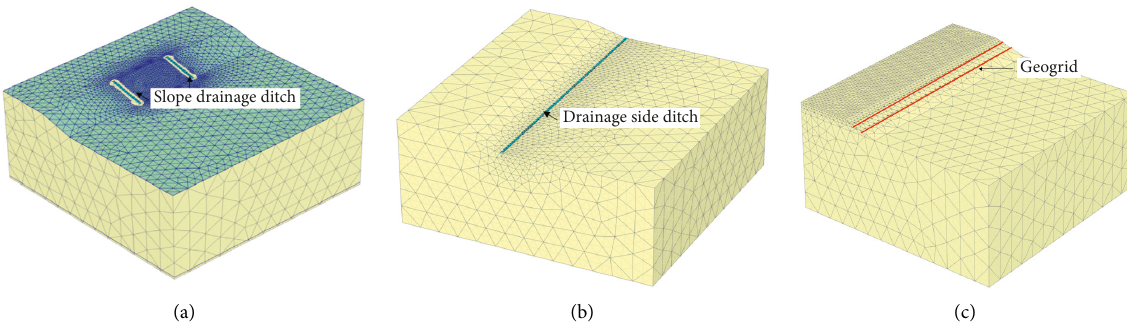
Figure 10: Three different slope protection measures. (a) Slope drainage. (b) Bottom edge. (c) Geogrid